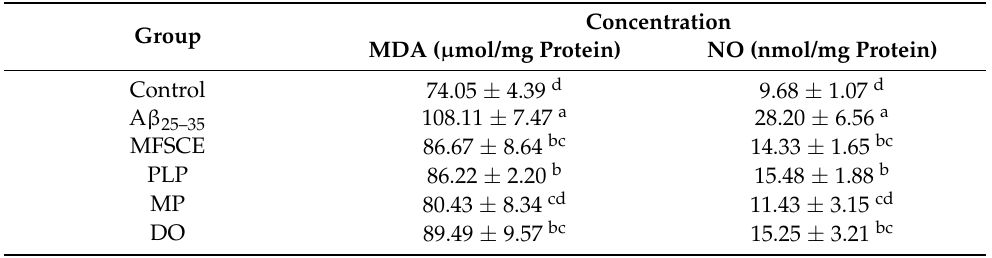
Table 2. Effect of MFSCE on lipid peroxidation and NO generation in the brain of A β 25–35 -injected